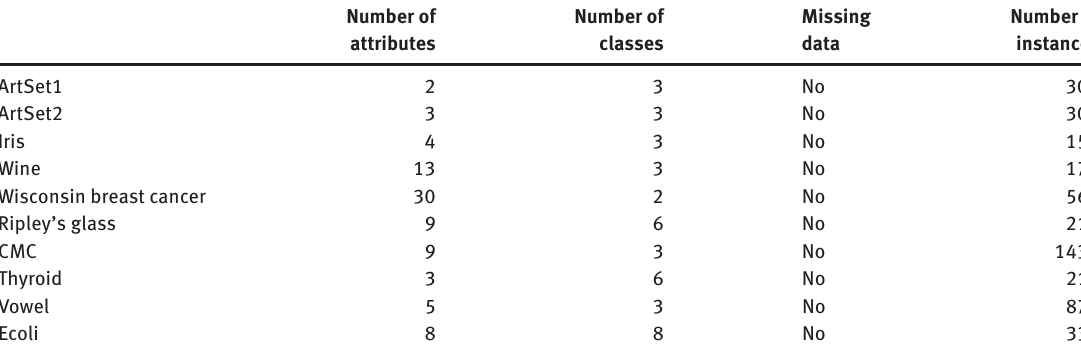
Table 1: Properties of Eight Real Data Sets from UCI Data Repository and Two Artificial Data